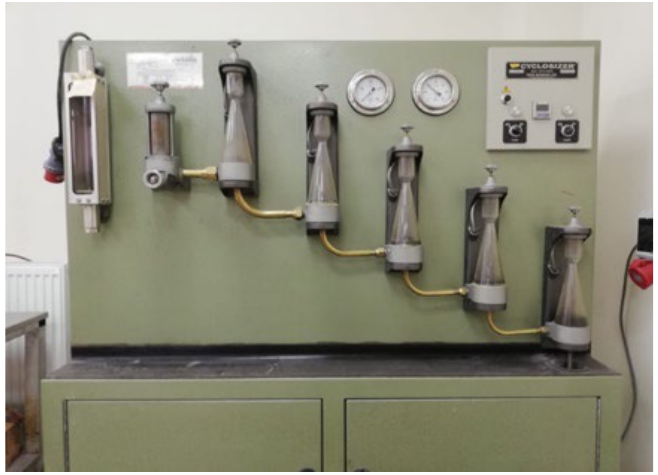
Figure 6. Cyclosizer test rig.